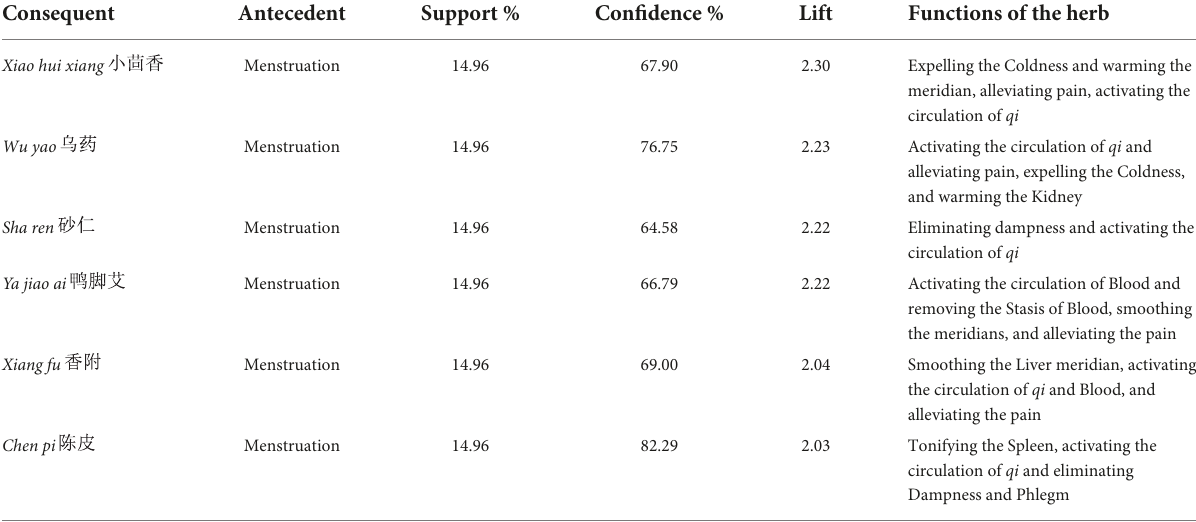
TABLE 7 Association rules between comorbidities/triggers and herbs.